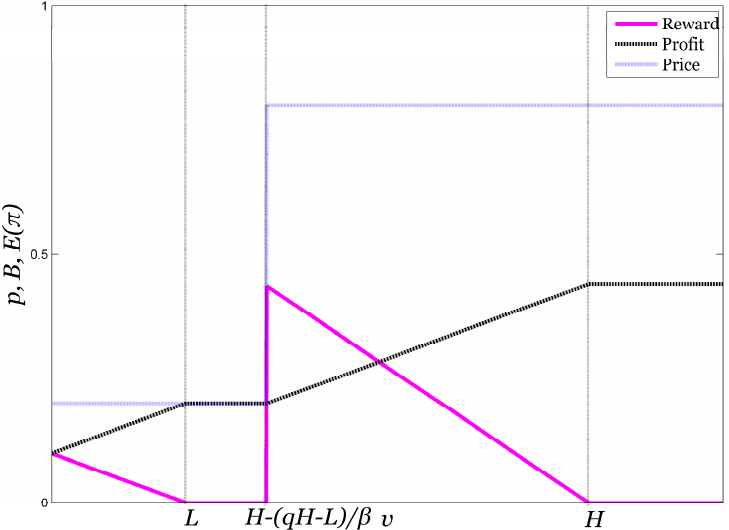
Figure 3. Optimal solutions according to product valuation ( (cid:1834) (cid:3404) 0.8 , (cid:1838) (cid:3404) 0.2 , β (cid:3404) 0.5 and (cid:1869) (cid:3404) 0.55